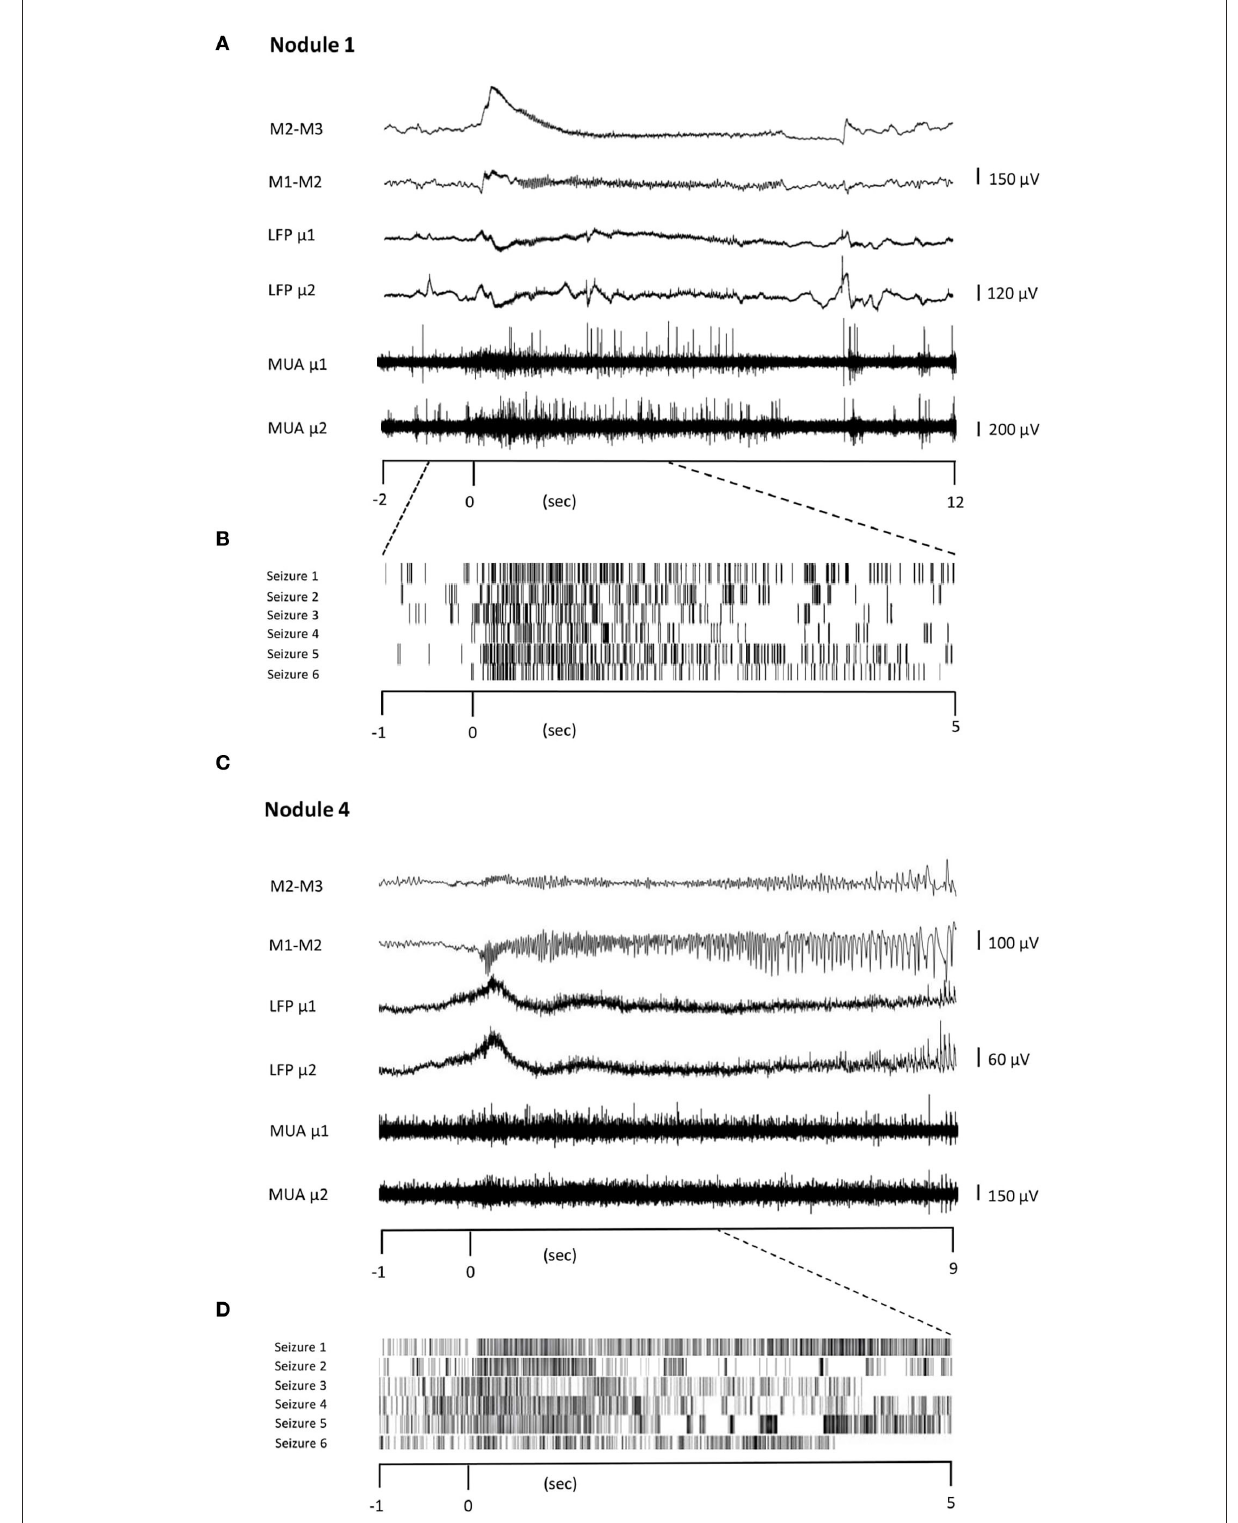
FIGURE4 Unit firing behavior during seizures. Two representative seizures originating from Nodule 1 (A) to Nodule 4 (C) , respectively. The ictal activity from two adjacent contacts of the macroelectrode (M1–M2, M2–M3, bipolar montage) is reported together with that obtained from two different microelectrodes ( µ 1 and µ 2). The microelectrode activity is then shown as LFP and MUA activity. TRaster plot, time-locked to seizure onset, for Nodule 1 (B) and Nodule 4 (D) . In the raster plot, different shades of gray denote different units. Each line of the raster plot shows the unit’s behavior during a seizure. The first line in the raster plot corresponds to the seizure shown above. Note that the units are the same as those analyzed for IEDs, here showing that they are also recruited during